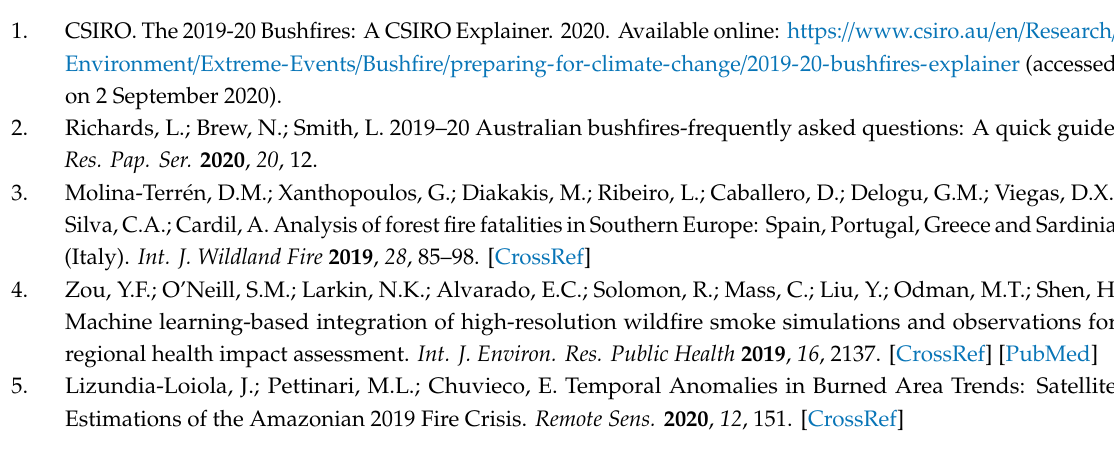
Figure A10. Annual burned areas in the Northeast China region.